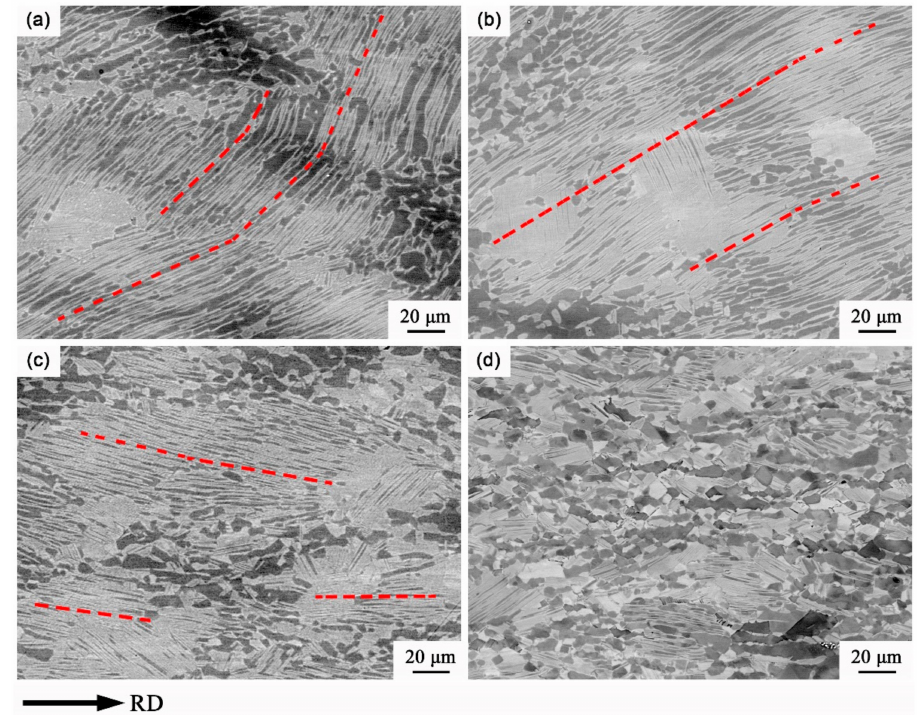
Figure 6. Microstructural evolution of the pack-rolled Ti-46Al-8Nb alloy with the di ff erent deformation degrees: ( a ) 30%, ( b ) 40%, ( c ) 60%, and ( d ) 80% (the horizontal direction is the rolling